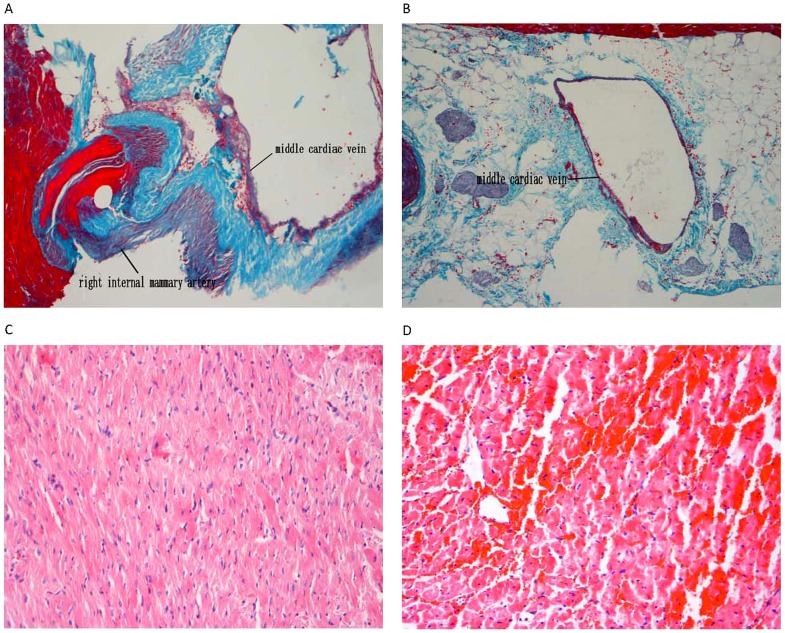
Histological changes in 3-month follow-up of experimental and control groups.(A) Experimental group—three months after ligation, no thickening or fibrosis was found near the ligation site. (B) Control group, middle cardiac vein. (C) Experimental group, region of ischemia. (D) Control group, region of ischemia, showing disordered arrangement of myocytes with cell swelling and karyorrhexis.